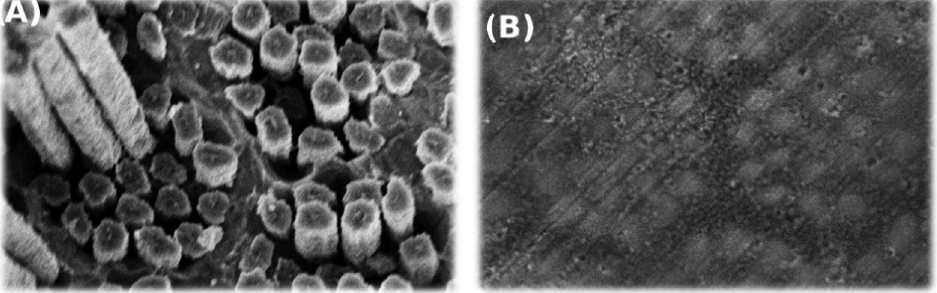
FIG. 3. (a) Scanning electron micrograph pictures of an etched cathode with Nb 3 Sn columns. The typical length of the freestanding columns is several tenths of (cid:2) m . Some of the columns are broken to visualize the column length (several 10’s of (cid:2) m ). (b) Nonetched, polished